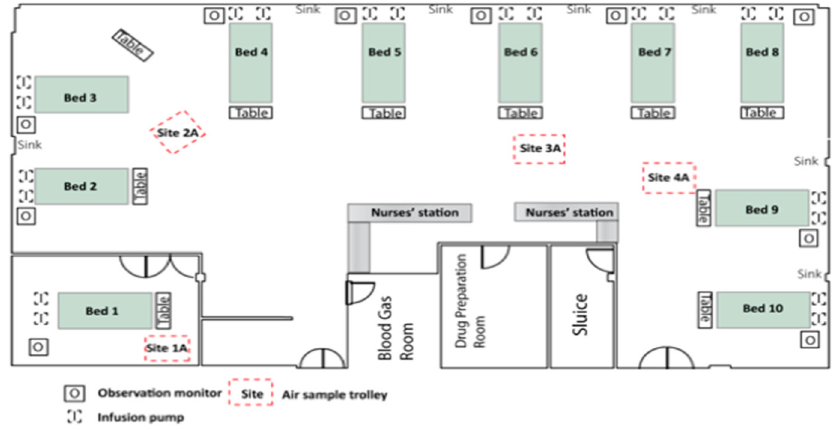
Figure 1. Aerial view of ICU (intensive care unit)